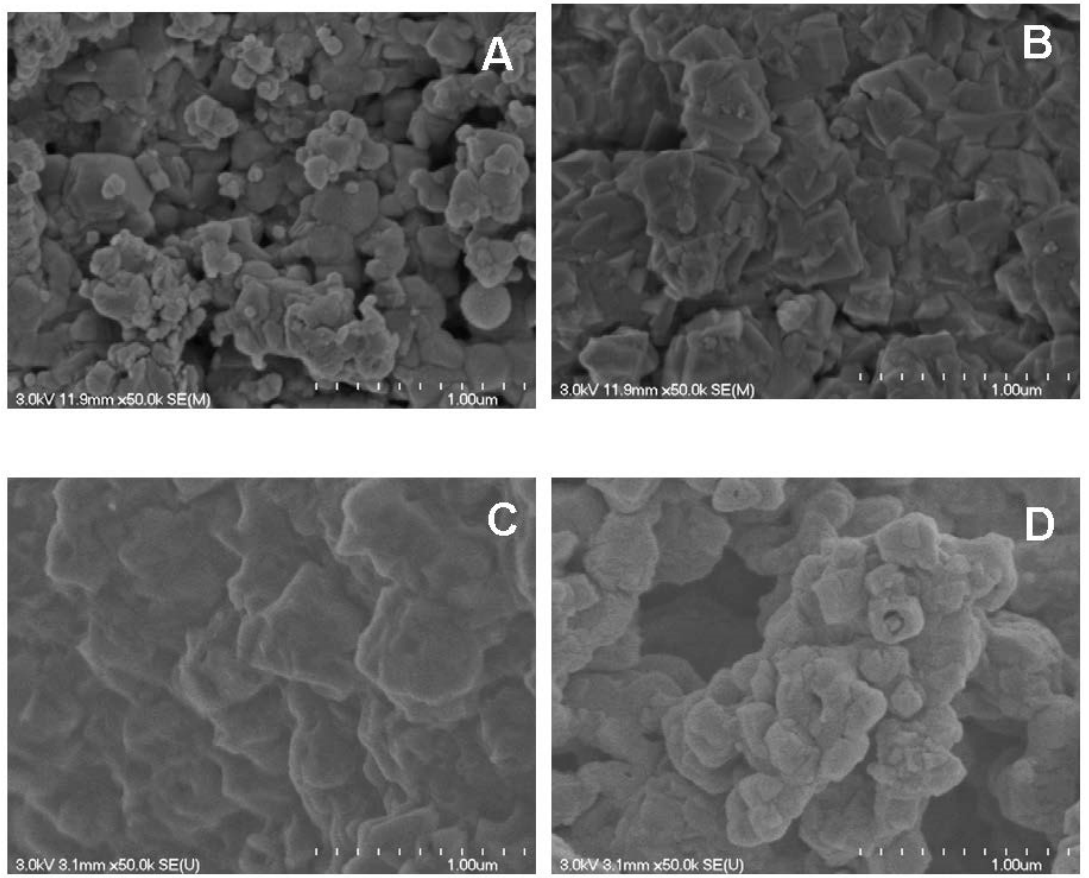
Figure 9. Micrographs of Ni-UGSO after bio-oil MemU SR at 800 ◦ C: ( A , B ) WHSV = 1.7 g/g cat /h; and ( C , D ) WHSV = 6.6 g/g cat /h.